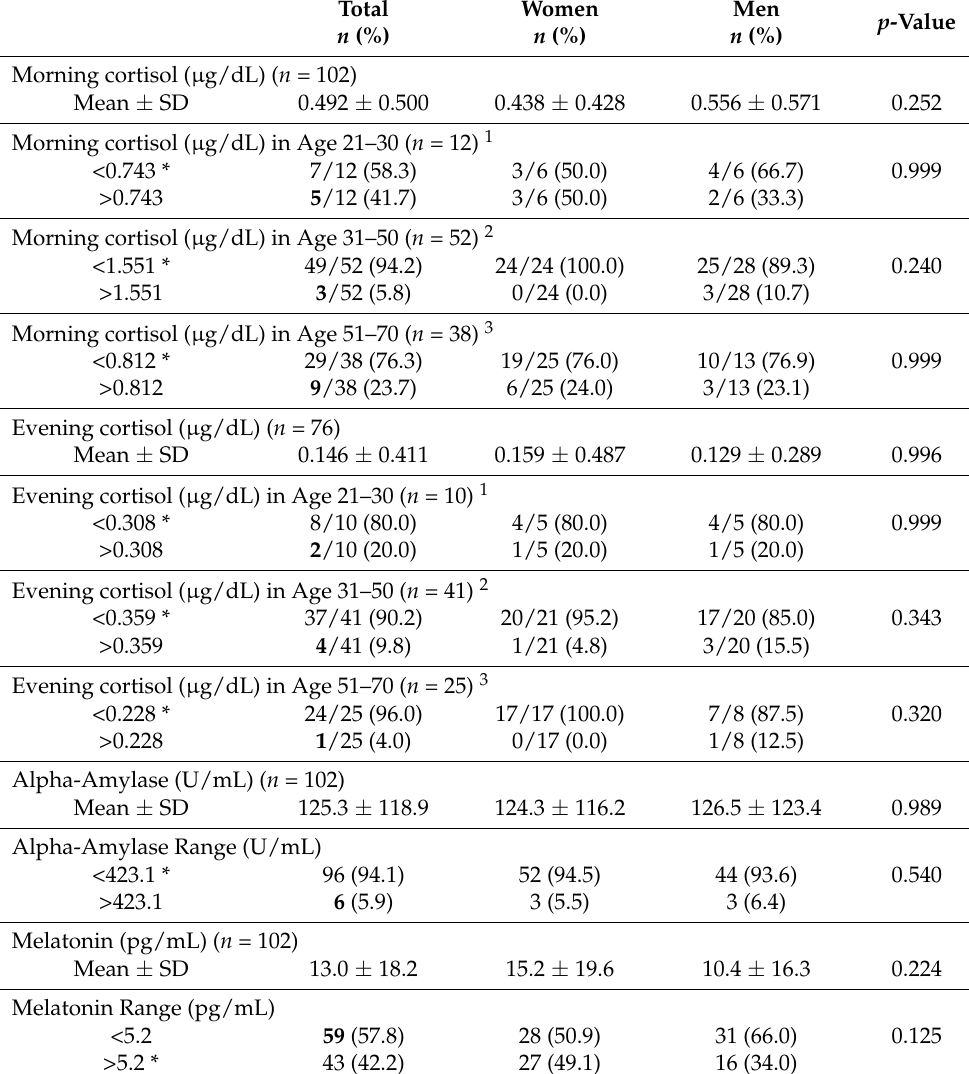
Table 2. Levels of measured salivary biomarkers, differences upon stratification in male and female subgroups. Total